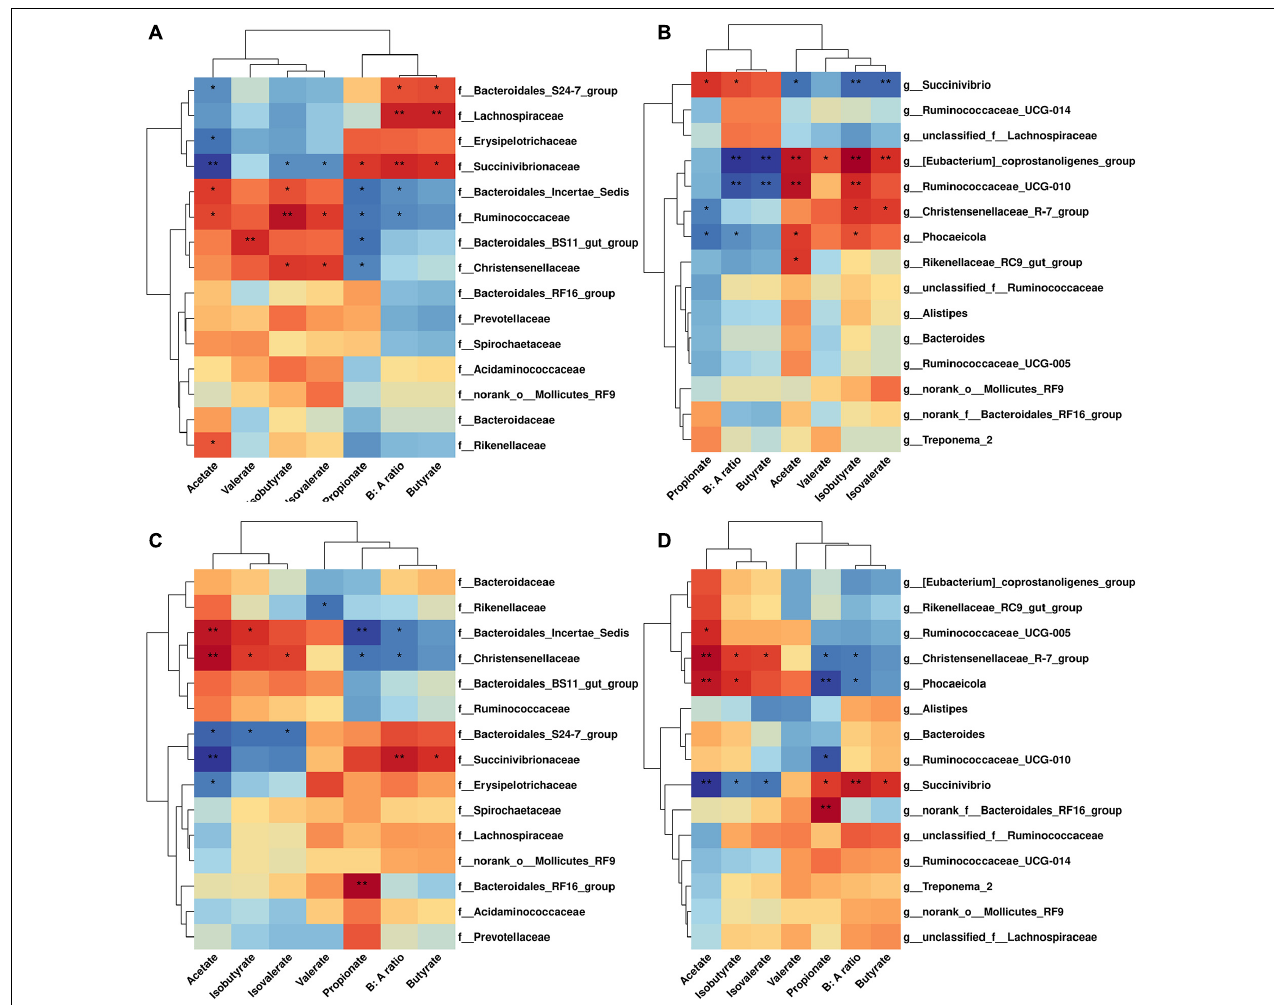
FIGURE 4 | Correlation analysis between microbiome abundance and SCFAs concentration in cecum and rectum. (A) Family level in cecum. (B) Genus level in cecum. (C) Family level in rectum. (D) Genus level in rectum. Cells are colored based on spearman correlation coefficient. Only relative abundance of the 15 most-abundant bacterial families or genera are